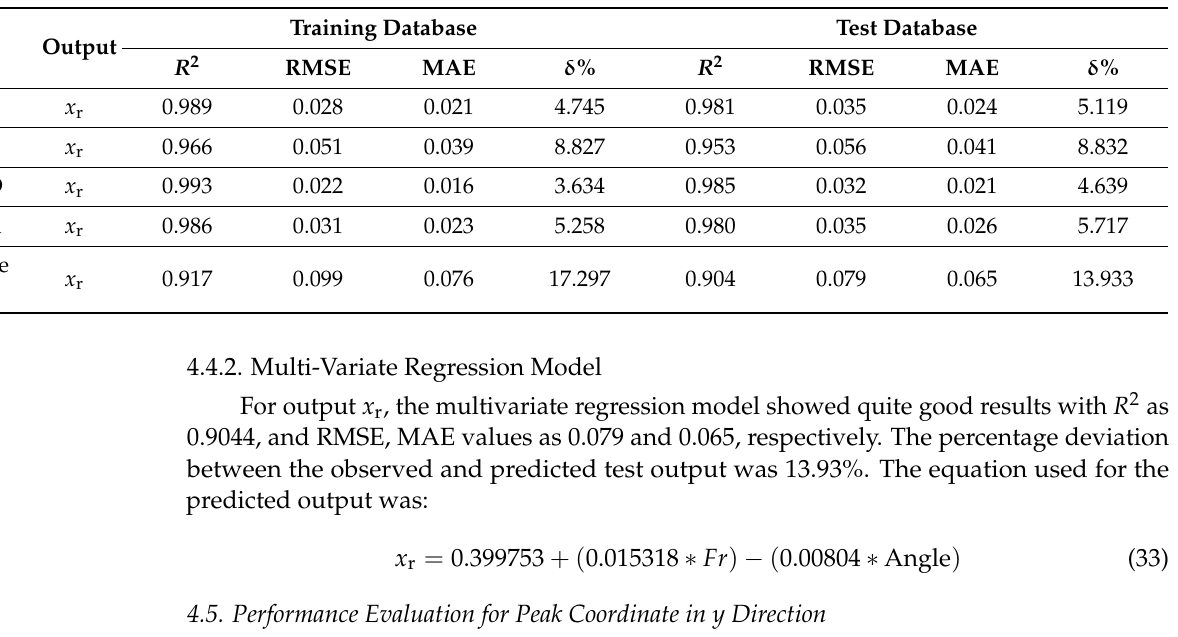
Table 5. Performance Evaluation for all the models for output x r